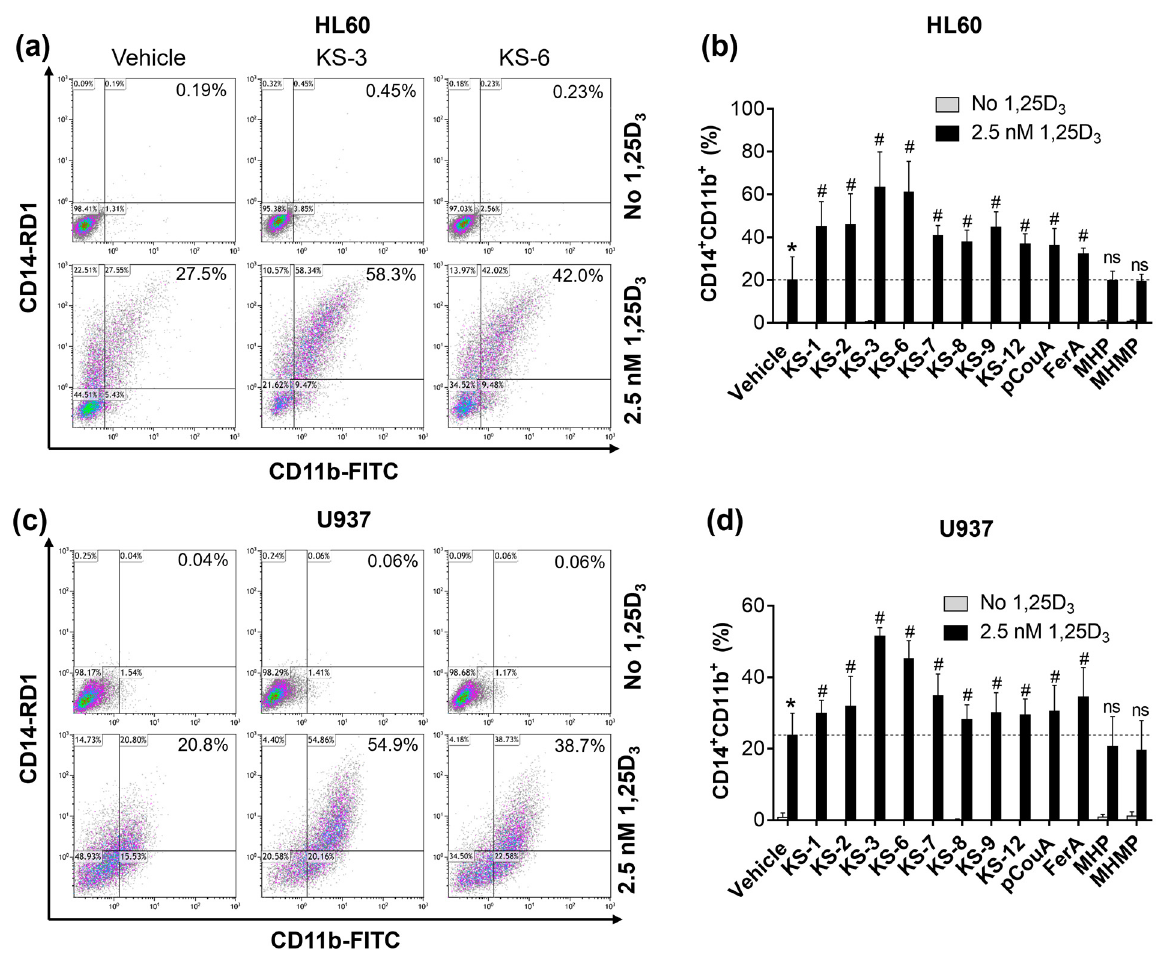
Figure 8 Figure 8. Hydroxycinnamic acids and their derivatives enhance the differentiation-inducing activity of calcitriol in AML cells. HL60 ( a , b ) and U937 ( c , d ) cells were treated with para-coumaric acid (pCouA), ferulic acid (FerA) or their derivatives (5 µ M), calcitriol (1,25D 3 ; 2.5 nM) or their combinations, for 96 h. Expression of surface myeloid differentiation markers was measured by flow cytometry. ( a , c ) Typical flow cytometric data obtained in representative experiments. The percentages of cells that are double-positive for CD14 and CD11b (CD14 + CD11b + ) are shown in the upper right quadrants. ( b , d ) Averaged percentages of cells double-positive for CD14 and CD11b. The data are the means ± SD ( n = 5). *, p < 0.05 vs. vehicle. #, p < 0.05, effect of a combination vs. sum of the effects of single agents; Student’s t test;